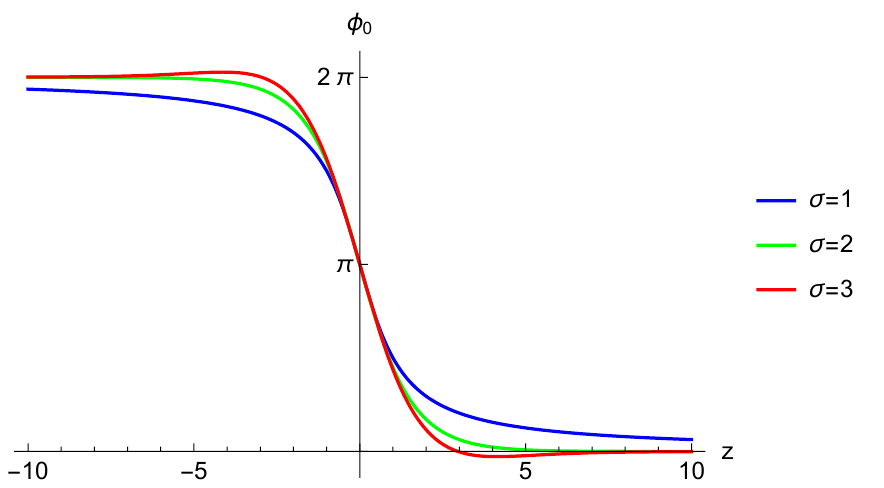
Figure 1 . Solutions to D σ φ 0 ( z ) = − sin( φ 0 ( z )) with σ = 1 , σ = 2 , and σ = 3 . The σ = 3 solution is generated for N = 50 , ∆ = 0 . 4 , and S ( x ) = 1